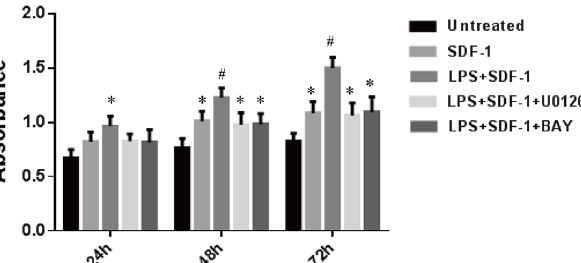
Fig 4. Effects of LPS on the SDF-1-induced proliferation of RF/6A cells. Cell proliferation was measured by CCK-8 at 24, 48 and 72 h. RF/6A cells pretreated with LPS (1 μ g/ml) for 24 h proliferated significantly in response to SDF-1 (100 ng/ml), but this effect was attenuated by treatment with U0126 or BAY 11 – 7082. Data are mean ± SD for three independent experiments. Statistical significance determined using one-way ANOVA with * P < 0.05, ** P <